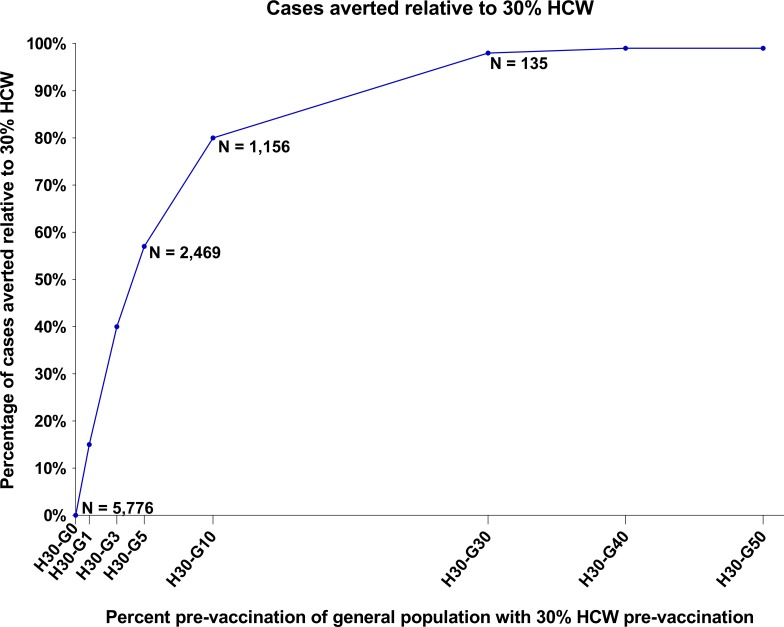
Incremental benefit of prophylactic vaccination of the general population as a function of the vaccination coverage.Abbreviations: HCW, health care worker; H30, vaccination of 30% of all HCW; H30-Gx, vaccination of 30% of all HCW plus x% of the general population.